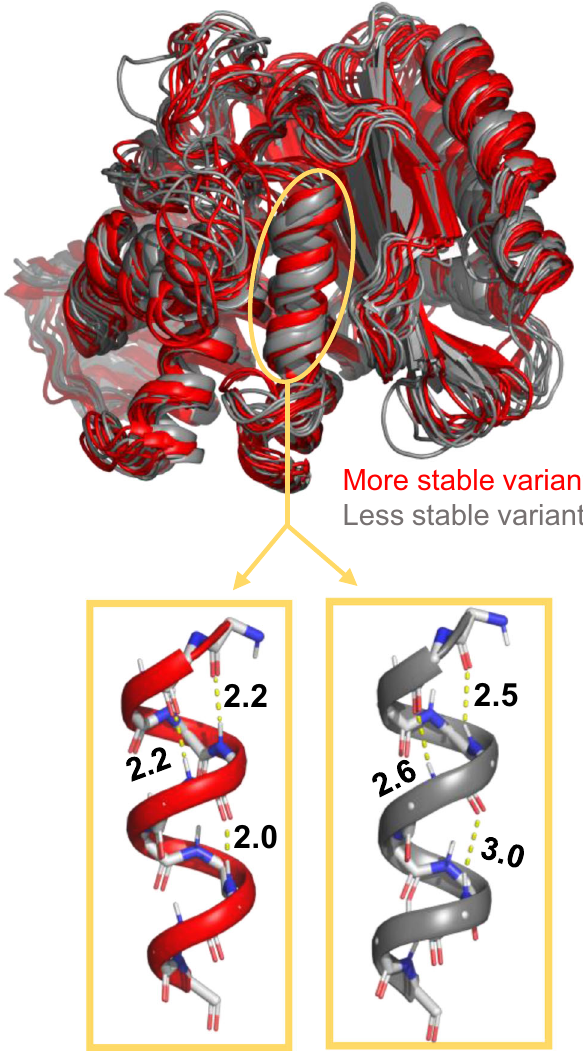
Fig. 2 Structural con fi gurations sampled from molecular dynamics simulations of wild-type TEM β -lactamase (gray) and an M182T variant (red) that is far more stable. Helix 9 is circled in yellow and shown below in a compact con fi guration (left, red) and a more extended con fi guration (right, gray). Hydrogen bond distances are shown in